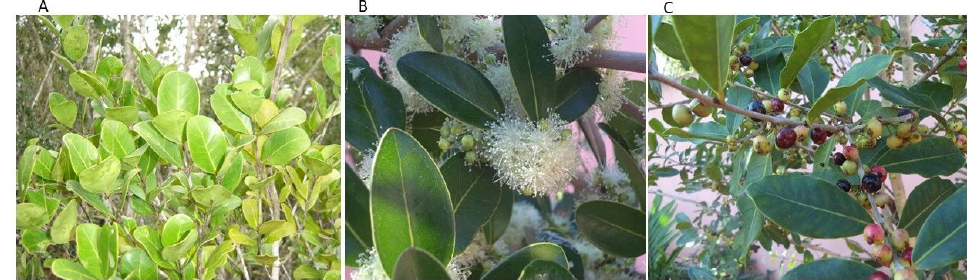
Figure 1. ( A ) Eugenia winzerlingii Standl., shrub in field, ( B ) flowers, and ( C ) fruits.